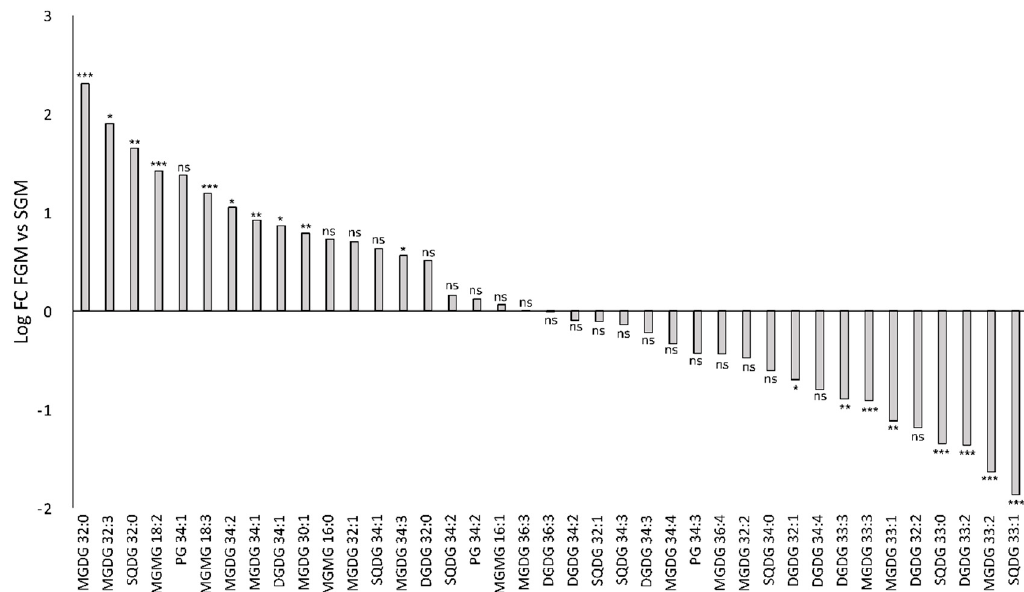
Figure 8. Comparison of abundance of selected lipid species detected in cells of Synechocystis sp. PCC 60803 tolC -mutant strain cultivated in FGM and in SGM. Fold-changes were calculated by dividing the average peak area of a given lipid species detected in samples obtained in FGM ( n = 6) by the average peak area of the same lipid species detected in samples obtained in SGM ( n = 6). The log 2 fold-change values are presented: positive values correspond to higher peak area in FGM compared to SGM, while negative values represent peak areas higher in SGM in comparison to FGM. Mann-Whitney unpaired analysis, * p < 0.05, ** p < 0.01, *** p < 0.005, ns: not statistically significant difference.